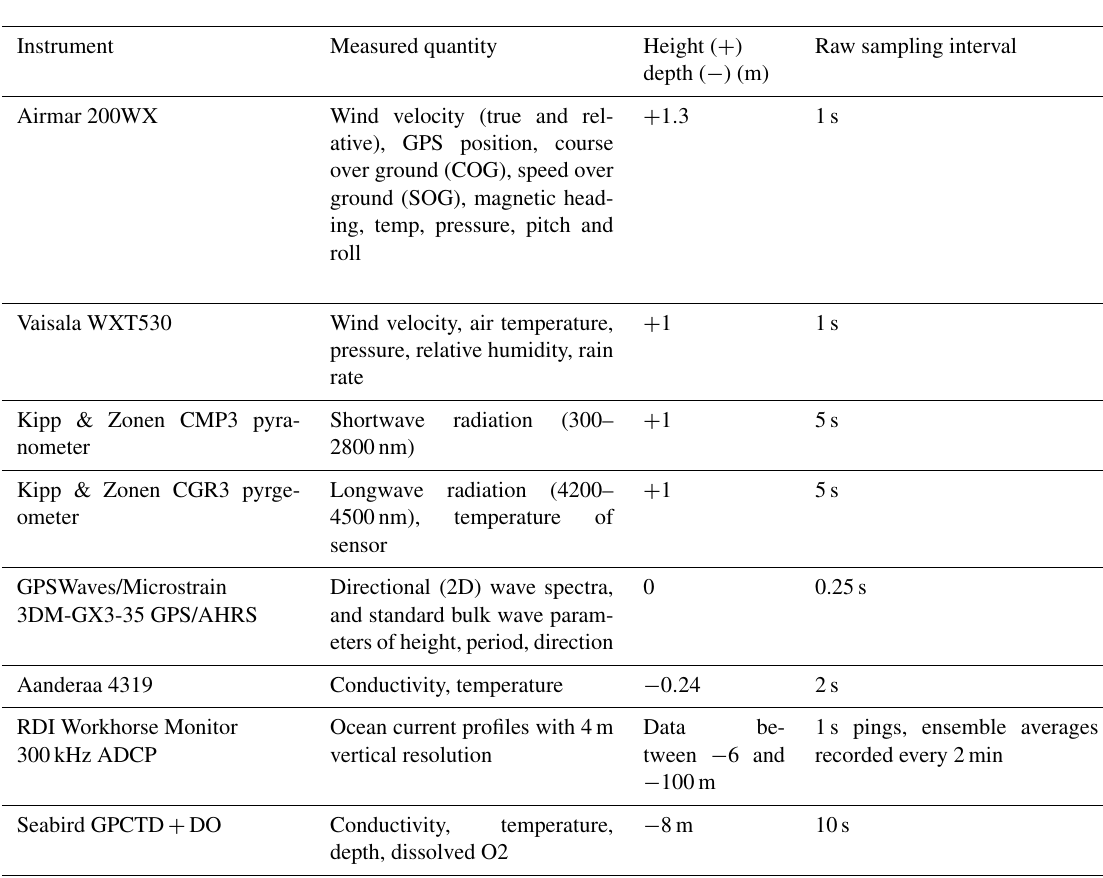
Table 7. Instrumentation on board the Wave Gliders for the measurement of atmospheric and seawater parameters. Data were collected during bursts lasting 20min at the top of each hour. Measurements were collected during 20min bursts every 30min. Final data products are 60min averages of high-resolution raw data within each hour and time-stamped at the beginning of the hour.